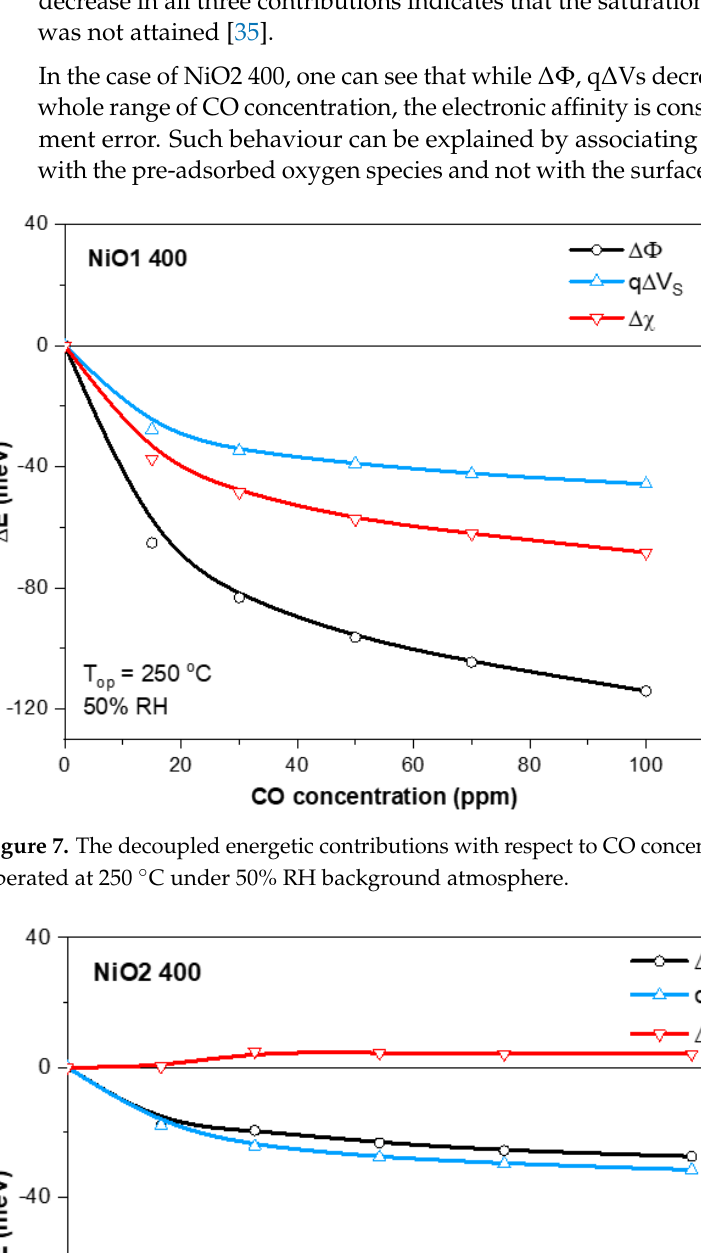
Figure 8. The decoupled energetic contributions with respect to CO concentration for NiO2 400 when operated at 250 °C under 50% RH background atmosphere.